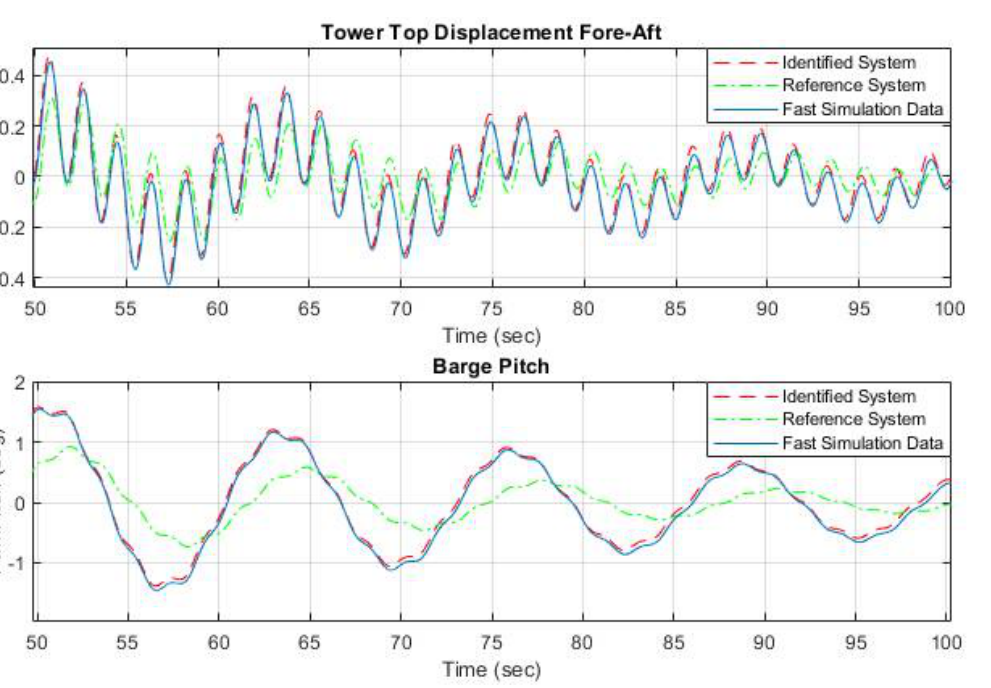
Table 7. Identified parameters of the selected dynamic FOWT model.